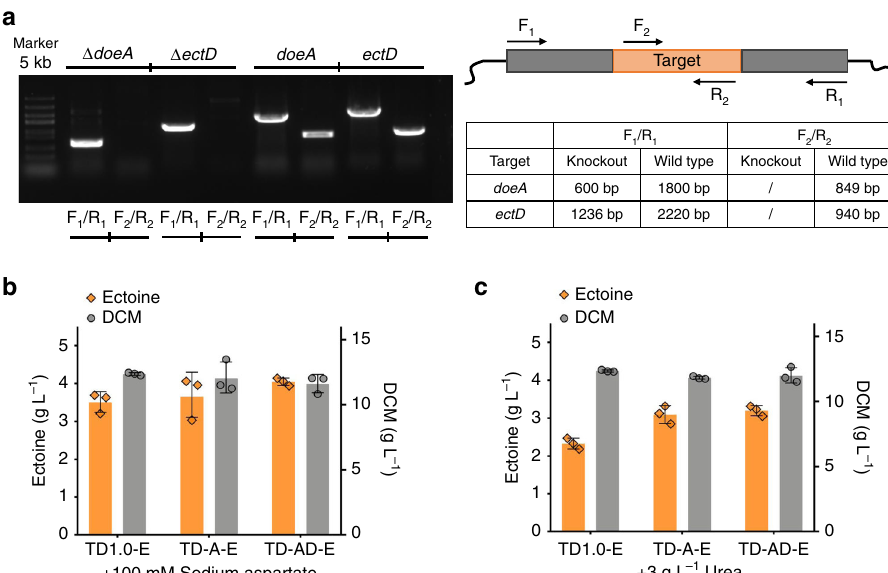
Fig. 4 Effect of deleting ectoine degradation genes doeA and/or ectD on ectoine synthesis. a Primer design and colony PCR results of doeA and ectD deletion for blocking the probable degradation of ectoine. b , c Performances of ectoine accumulation by various engineered H. bluephagenesis TD1.0 strains, respectively, strain TD1.0: a start host, strain TD-A: single-deletion of doeA , and strain TD-AD: double-deletion of doeA and ectD genes. Strains harboring the e ctABC expression module on plasmid-based systems, namely, strain TD1.0-E, TD-A-E, and TD-AD-E, respectively, induced with 20 mg L − 1 IPTG. b Cells cultured in 60MME medium, while ( c ) was grown in 60MMG medium supplemented with extra 3 g L − 1 urea (60MMU) for de novo biosynthesis of ectoine from glucose and urea only. Data are presented as mean values, error bars represent standard deviations (SD); n = 3 biologically independent samples. Source data are provided as a Source Data fi le.